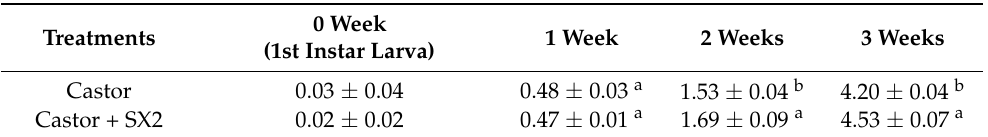
Table 2. Weight (g) of Eri silkworm reared with castor leaves and E. hirae SX2 supplemented castor leaves during 3 weeks of cultivation.